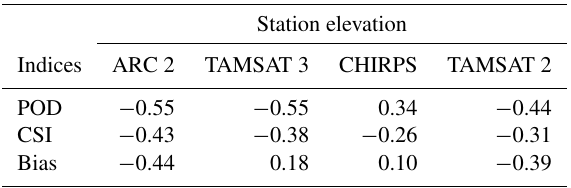
Table 2. Pearson correlation between the skills of SREs and station elevations (only important correlations are presented here). Proba- bility of detection (POD), critical success index (CSI), and bias. Station elevation Indices ARC 2 TAMSAT 3 CHIRPS TAMSAT 2 POD − 0.55 − 0.55 0.34 −